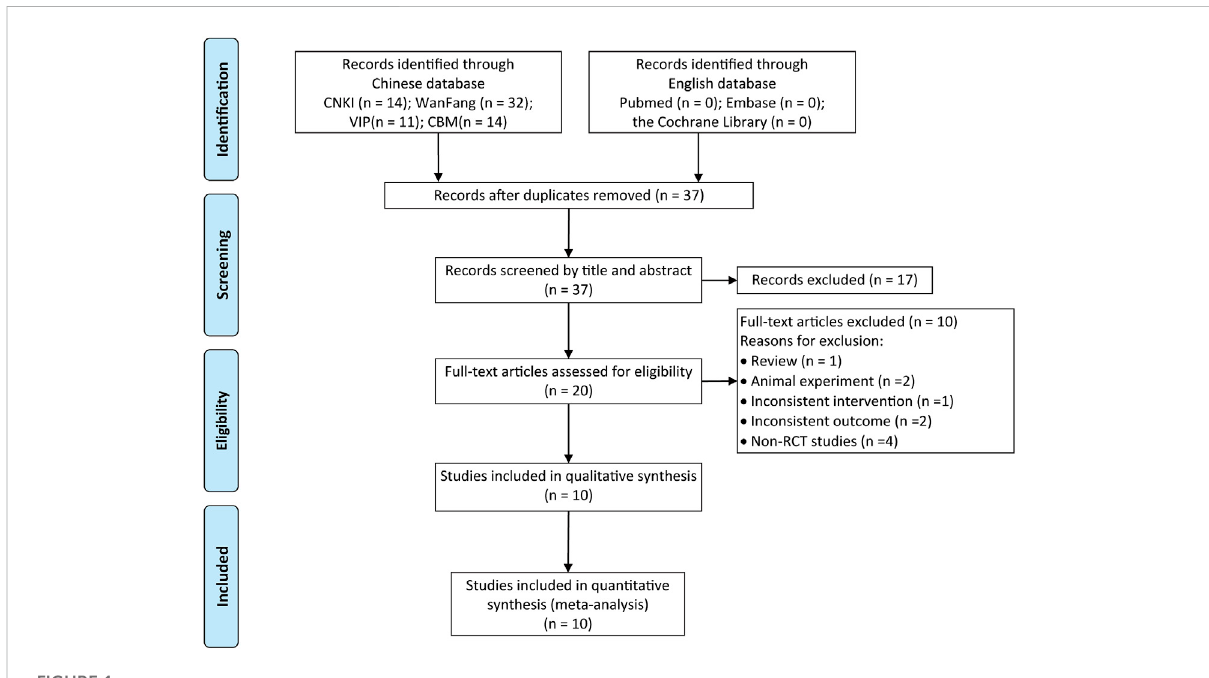
FIGURE 1 Literature screening